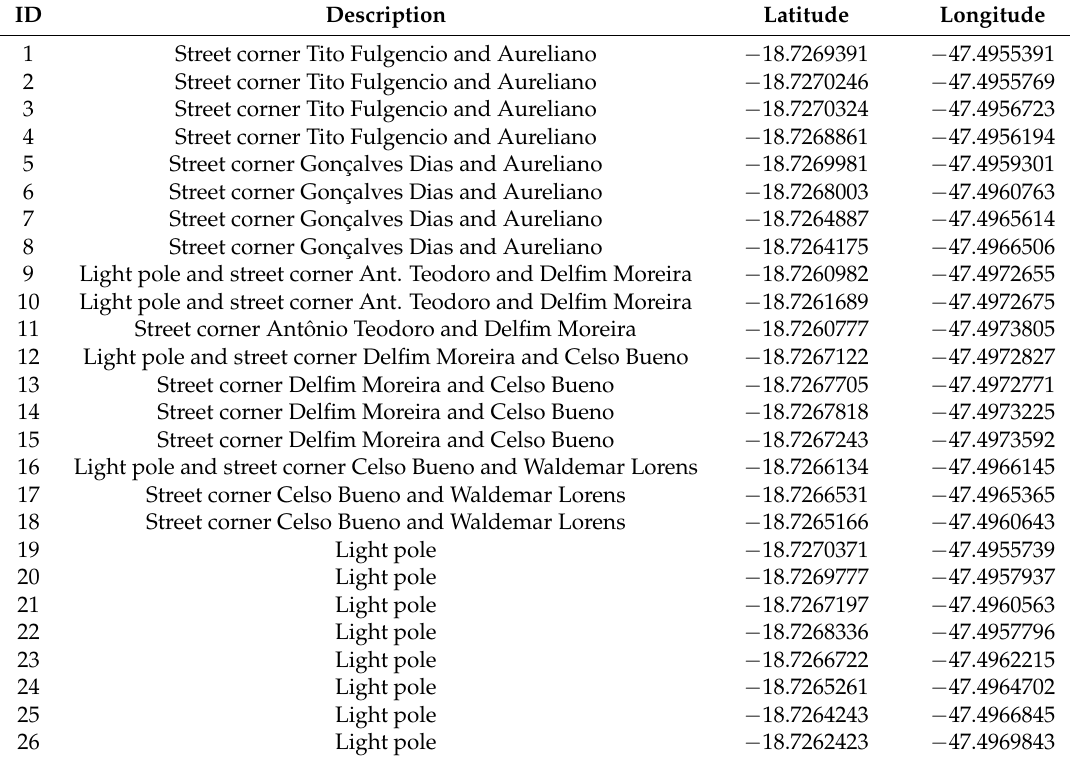
Table A1. Points of interest of the test area registered in the prototype